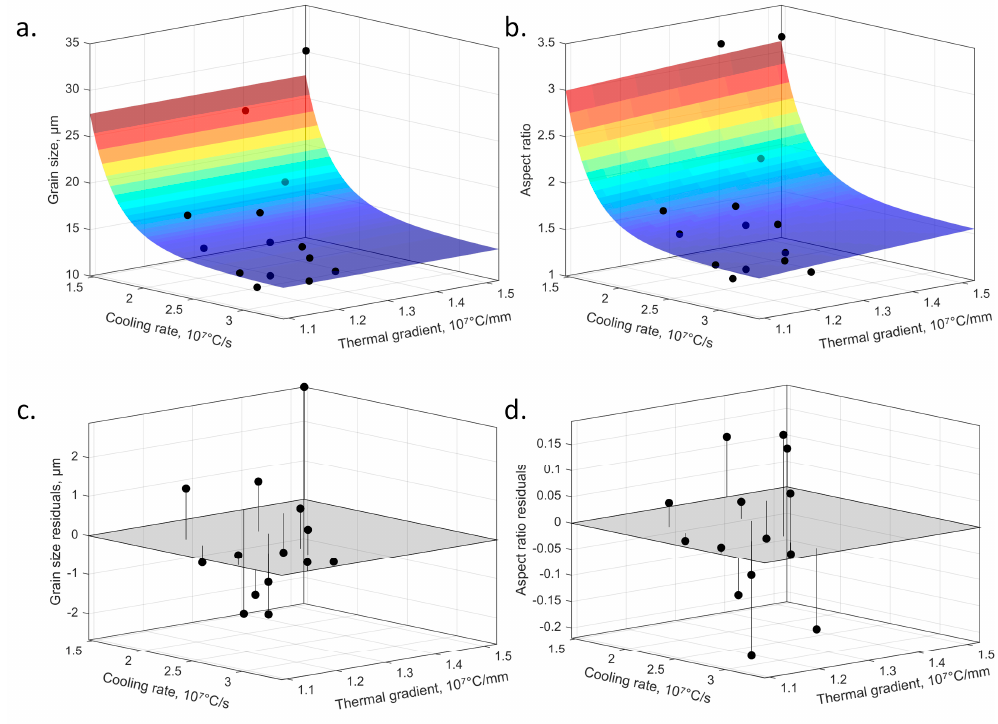
Figure 8. ( a ) Grain size (dxz) and ( b ) grain aspect ratio (GAR) as functions of CR and TG; ( c ) Grain size and ( d ) grain aspect ratio residuals.